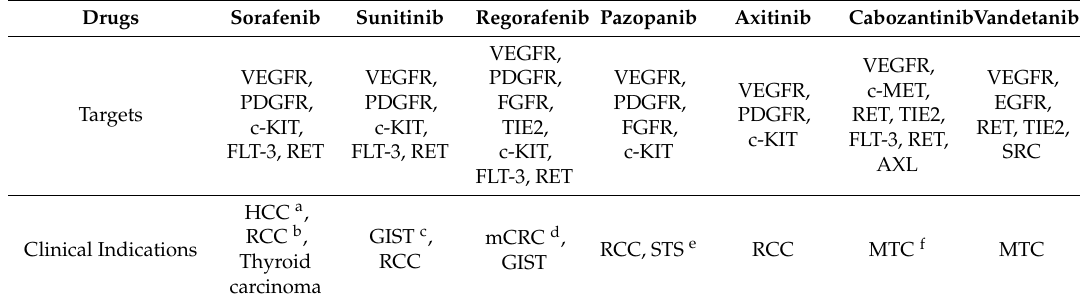
Table 3. Targeted therapy to tyrosine kinase domain including VEGFR.